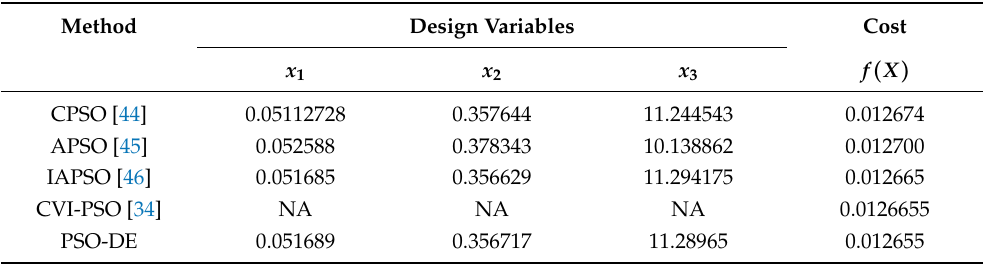
Table 11. Comparison of the optimal results of different algorithms for the pressure spring problem. NA indicates that it has not been addressed in the